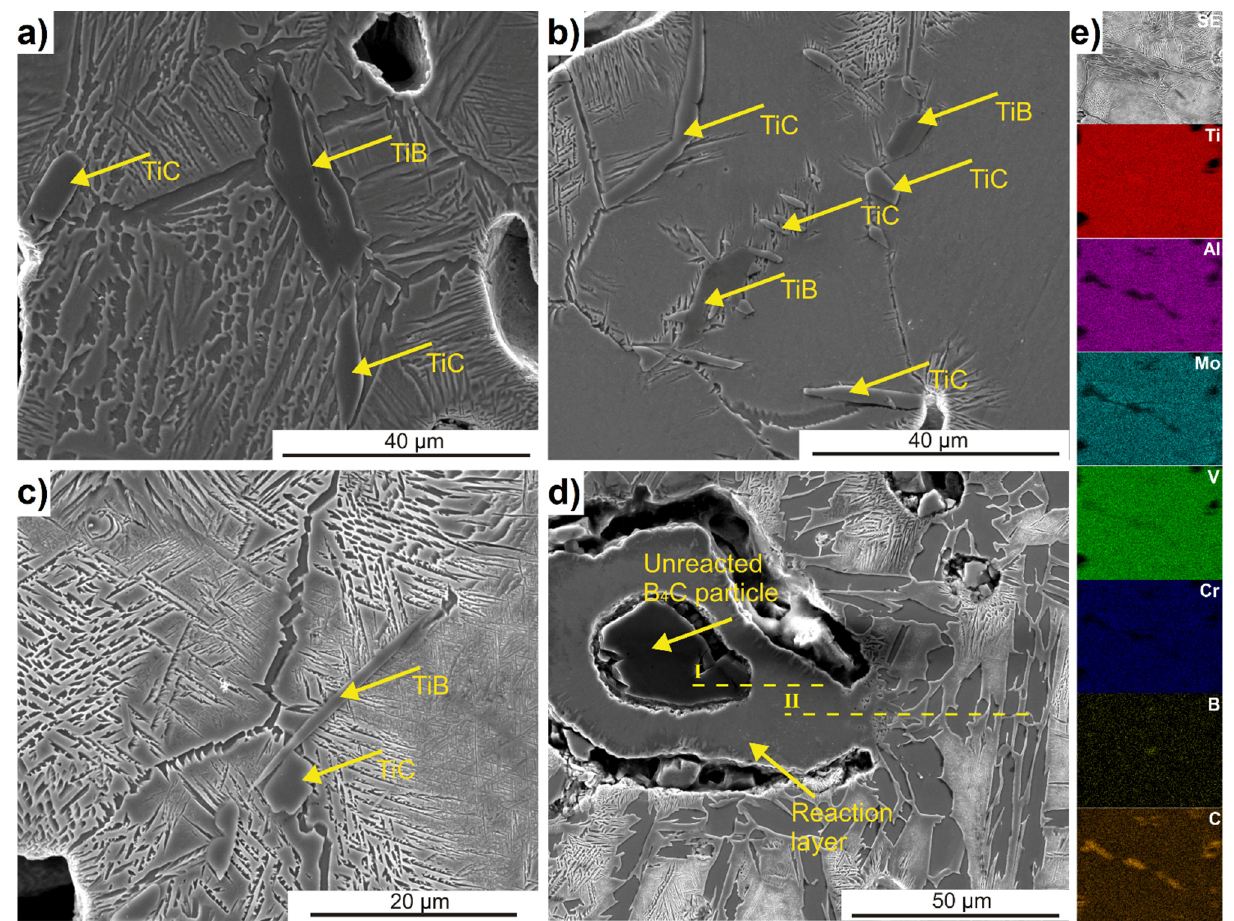
Figure 5. SEM micrographs of Ti-5553 + 2% B 4 C composite with ( a – c ) identified different in situ reinforcement phases, ( d ) unreacted B 4 C particle with marked EDS line scan, and ( e ) EDS mapping of TiC phase.